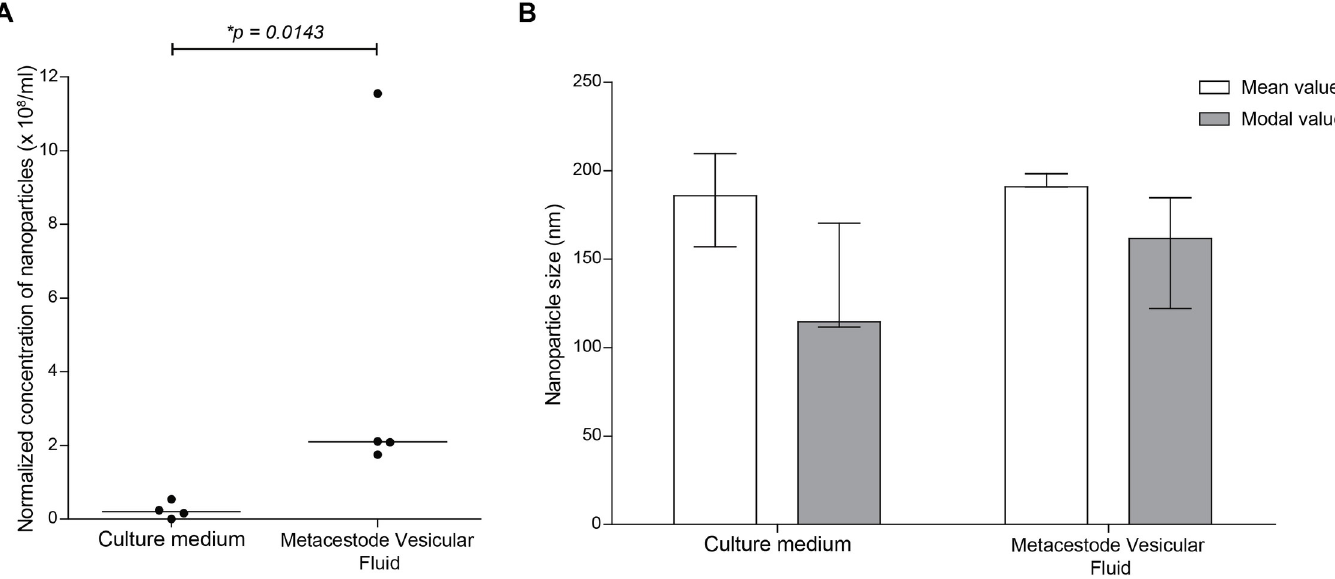
Fig 2. Nanoparticle tracking analysis of extra- (culture medium) and intra- (metacestodes vesicular fluid) parasite secretions of the E . multilocularis metacestode in vitro . A) Normalized concentration of nanoparticles expressed in number of nanoparticles/ml. Each dot represents a biological replicate and lines indicate the median values. B) Mean and modal size of the detected nanoparticles. Bars indicate median size with range of the corresponding value.